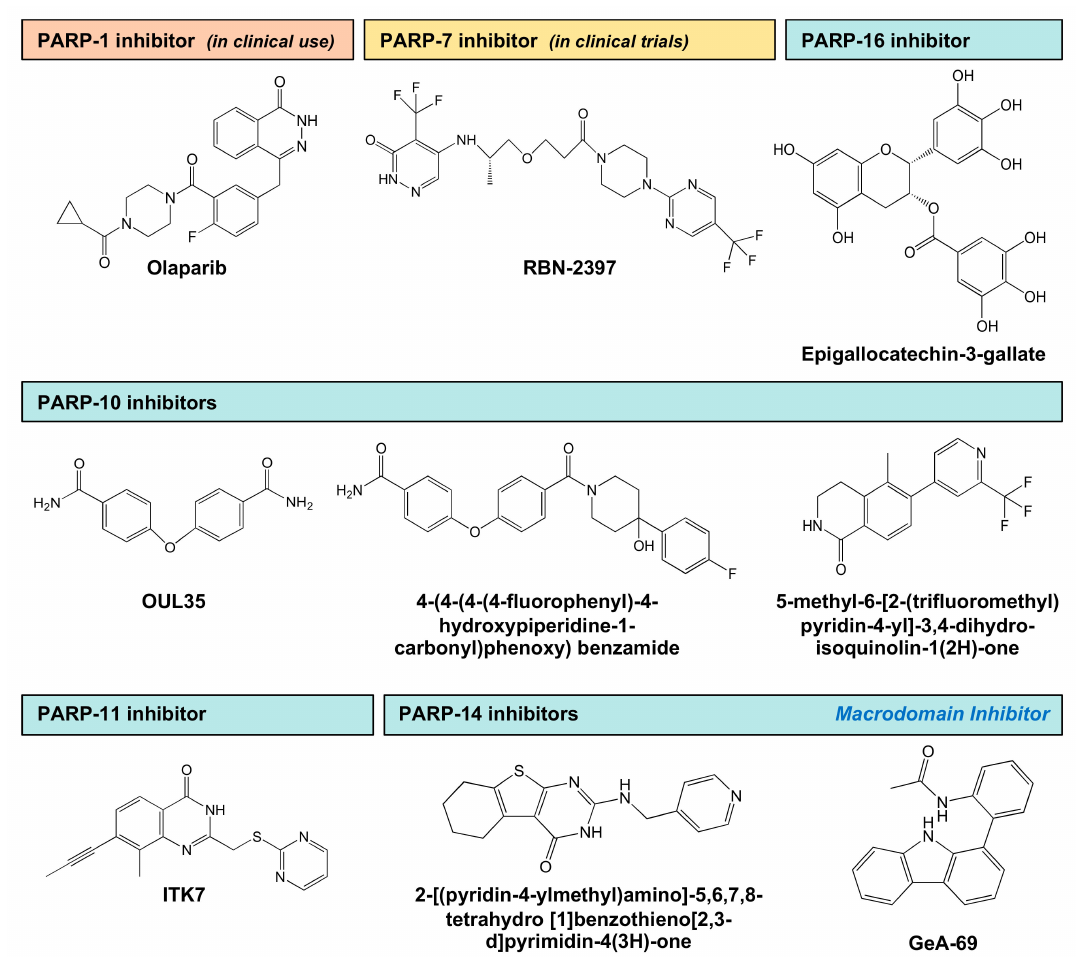
Figure 5. Chemical structures of PARP and MART inhibitors. The structure of the PARP-1 inhibitor, Olaparib, the first FDA-approved PARP inhibitor, is shown for comparison. The PARP-7 inhibitor, RBN-2397, is in Phase I clinical trials (ClinicalTrials.gov identifier: NCT04053673). All of the inhibitors shown target the catalytic domain of the PARPs, except the PARP-14 inhibitor GeA-69, which targets the macrodomains. See also Table